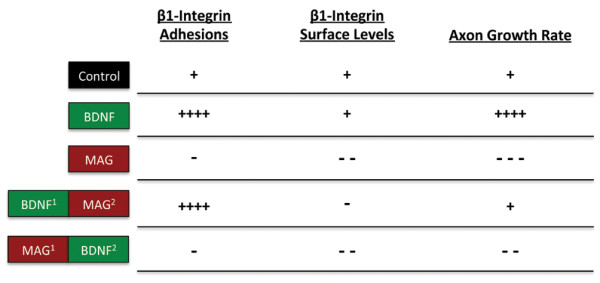
Comparison of bidirectional β1-integrin remodeling during nerve growth. Summary figure showing the clustering and global surface levels of β1-integrin in the growth cone correlated with the mean axon growth rate for the experimental treatments in Figure 6. Superscripts denote order of treatment. Symbols (+/-) denote positive and negative effects relative to controls.